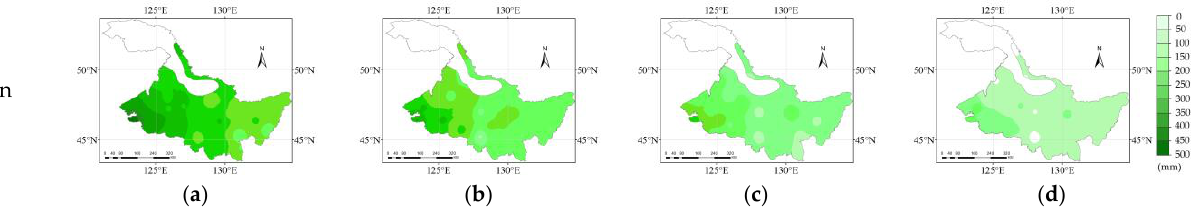
Figure 7. Spatial distribution of I r in extremely dry years ( a ), dry years ( b ), normal years ( c ), and wet years ( d ) under irrigation scenario.